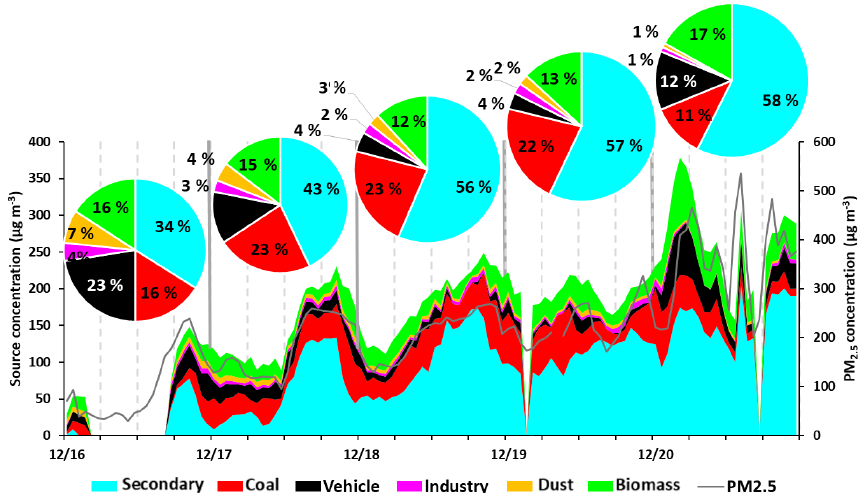
Figure 6. Source contribution in EP4. The pie charts show the daily source type and contribution. Dates are